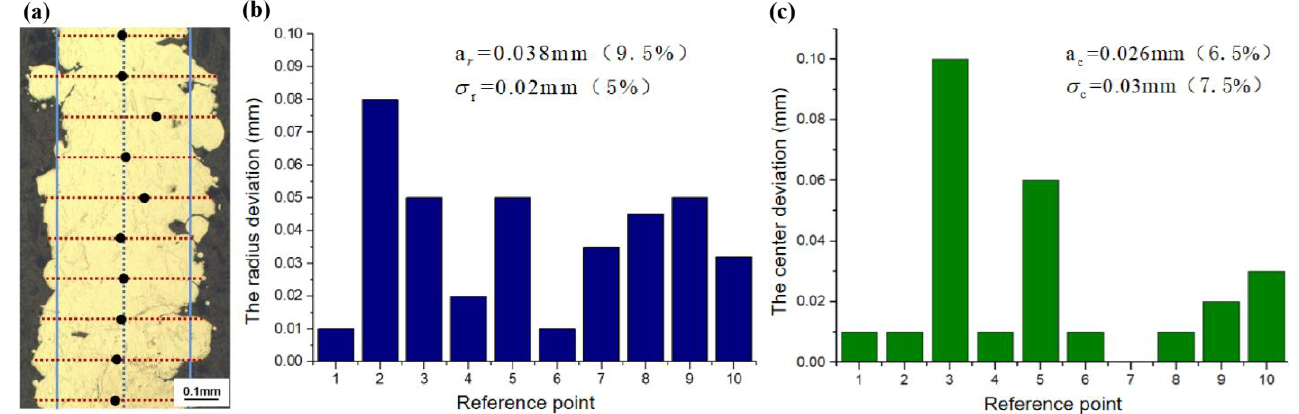
Figure 10. The actual diameter calibration method and difference value statistics between the as- printed micro-rod actual diameter and its 3D model: ( a ) the multi-point quantification calibration mode of the as-printed micro-rod diameter; ( b ) the positive deviation statistics of the as-printed actual and 3D model diameters; ( c ) the negative deviation statistics of the as-printed actual and 3D model diameters.